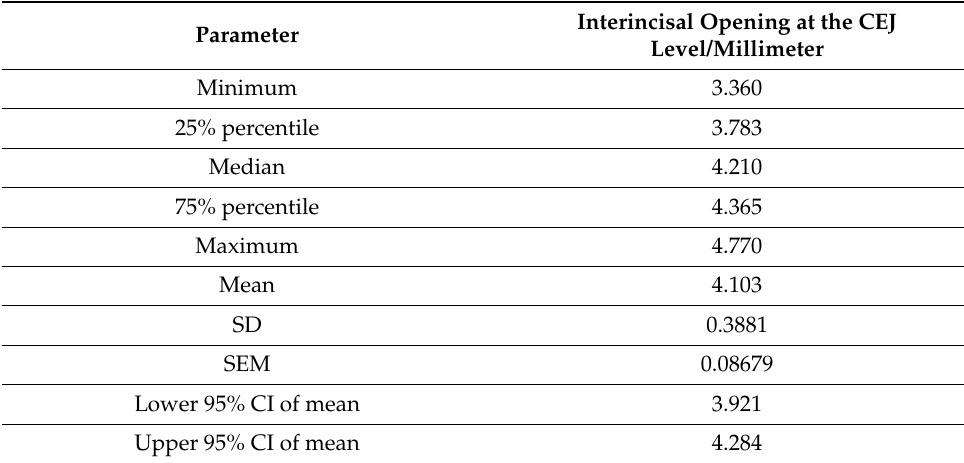
Table 3. The magnitude of the interincisal distance opening at the cemento-enamel junction (CEJ) level.